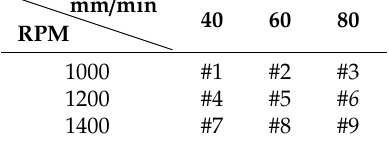
Table 4. Test conditions of fillet FSW process.